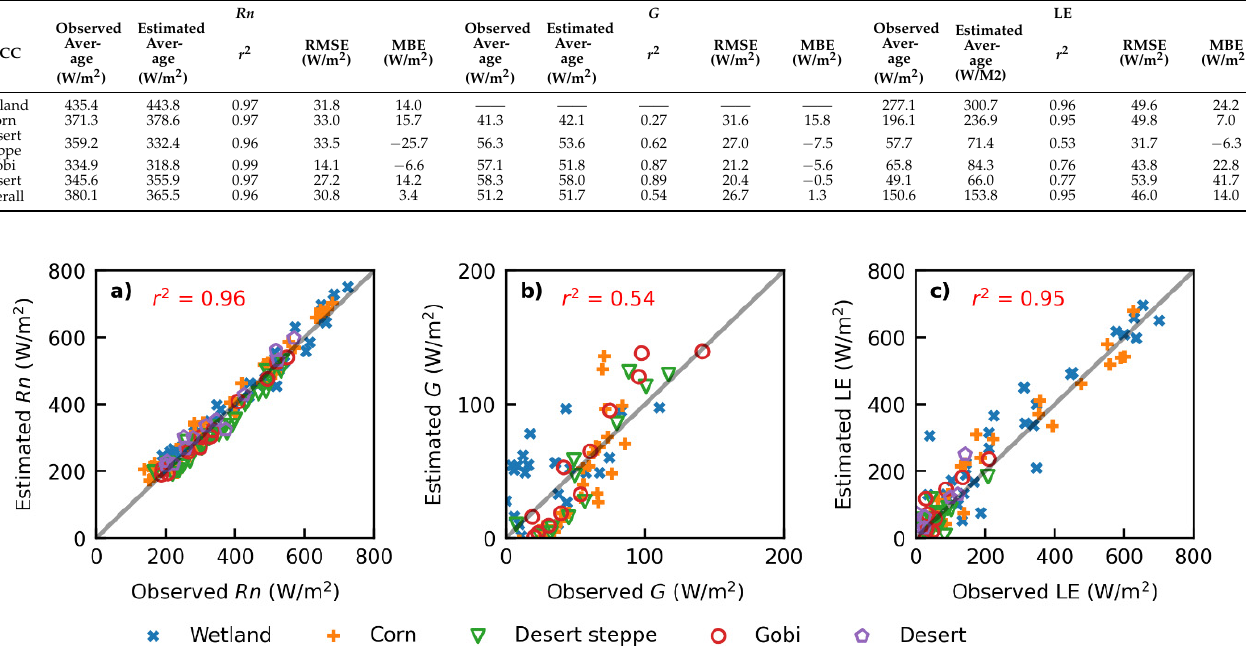
Figure 3. Comparisons of the observed and estimated results in five sites (wetland (Zhangye), corn (Daman), Desert steppe (Huazhaizi), Gobi (Bajitan), Desert (Shenshawo)) during long-term observation periods from 2013 to 2018. ( a ) Rn ; ( b ) G ; ( c ) LE from the WAPT model.